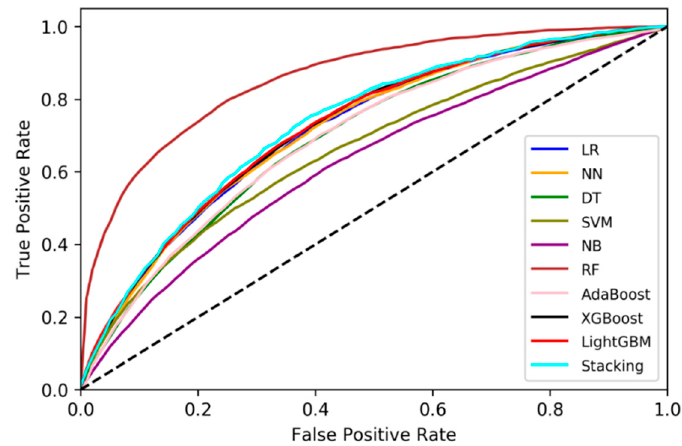
Figure 10. (Receiver Operating Characteristic) ROC curve comparing ensemble learning and individual classifiers.